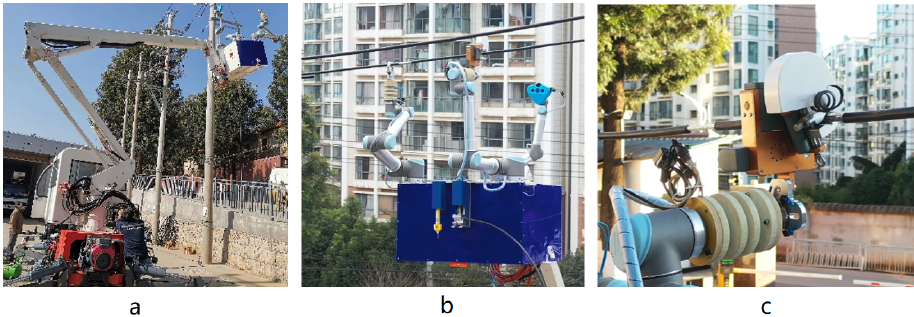
Figure 1. Schematic diagram of live-line working scene. (( a ) Insulated bucket vehicle, ( b ) robot system, and ( c ) stripping operations).